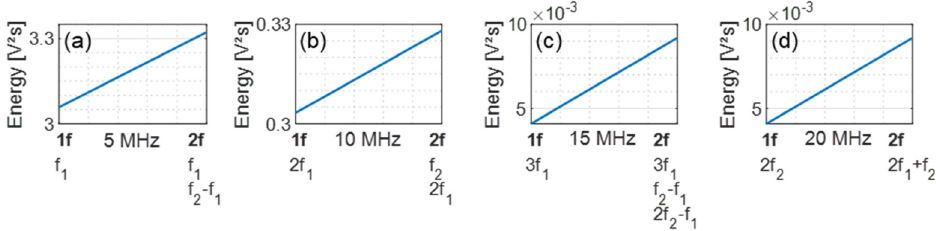
Figure 5. Energy comparison: ( a ) Group 1 (5 MHz); ( b ) Group 2 (10 MHz); ( c ) Group 3 (15 MHz); ( d ) Group 4 (20 MHz).